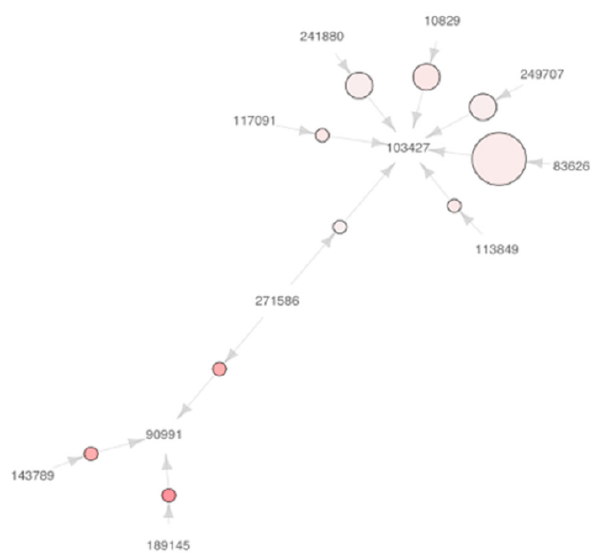
Figure 2. Association rule visualization for Scenario 1 Class 1-1. Note that the numbers indicate SKUs, size of circle indicates level of support (0.20–0.28) and color indicates level of lift (1.25–2.48).